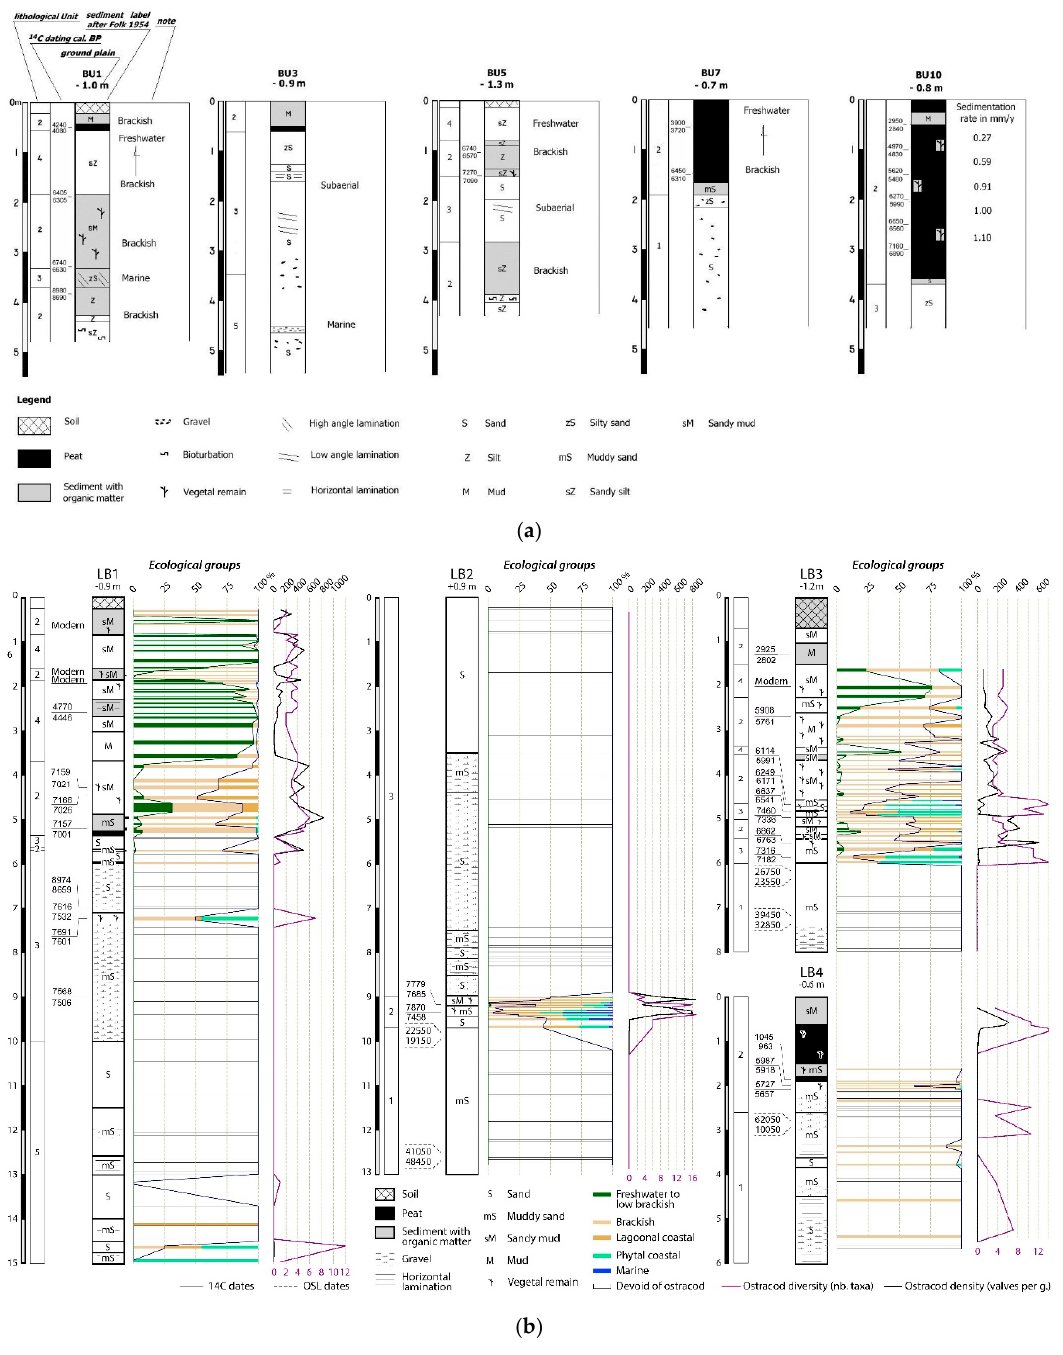
Figure 3. ( a ) Litho-stratigraphy and environmental evolution along BU1, 3, 5, 7, 10 percussion drillings. In BU10 core, the sedimentation rates in the peats are reported. ( b ) Litho-stratigraphy and ostracod ecological groups distribution along LB1, 2, 3, 4 continuous drillings. Age cal BP. • Unit 1—Ocher and locally cemented quartz silty sands (zS) constitute this unit. Rare fine gravel with occasional centimetric pebbles and local plane-parallel lamination are present. The medium-sorted sediment shows uni or bimodal grain-size distribution. This unit outcrops along